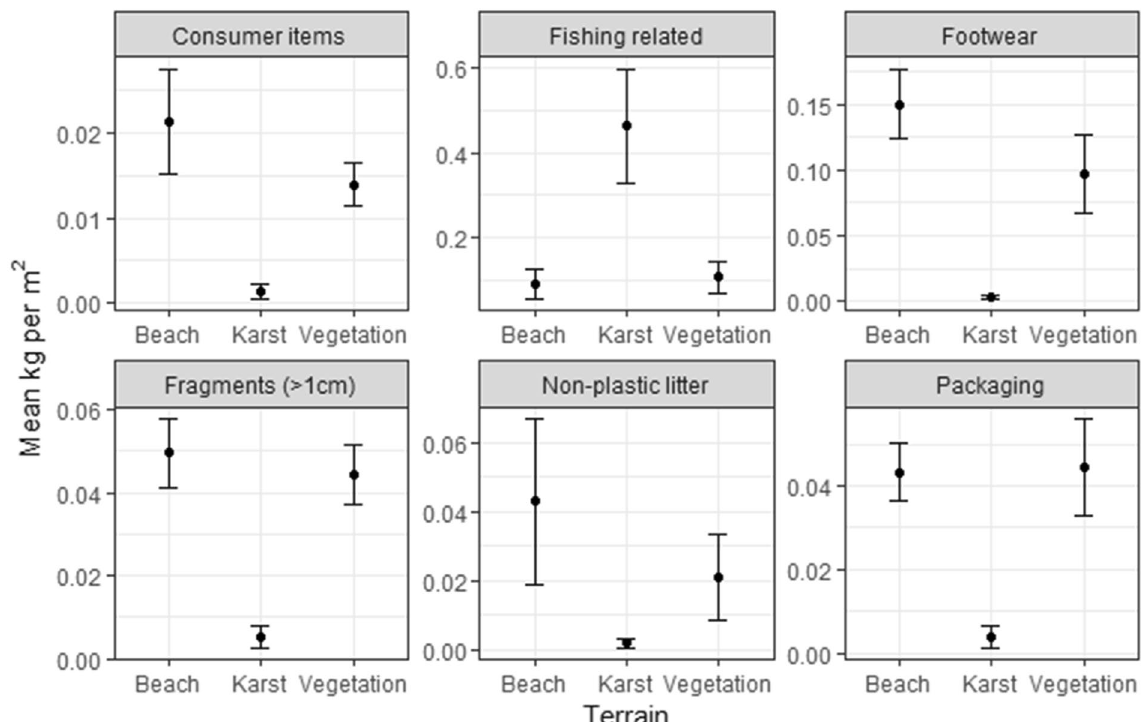
Figure 3. The amounts of plastic waste in each of six categories recorded in twenty transects in each of the three main terrain types (60 transects in total). Error bars show one standard error. The scale on the y-axis varies among plots.